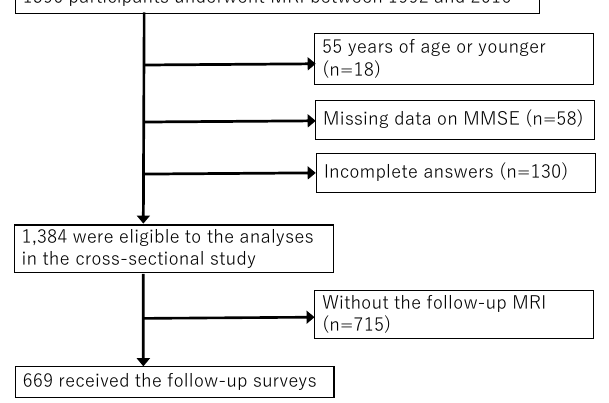
Figure 1. Overview of the study